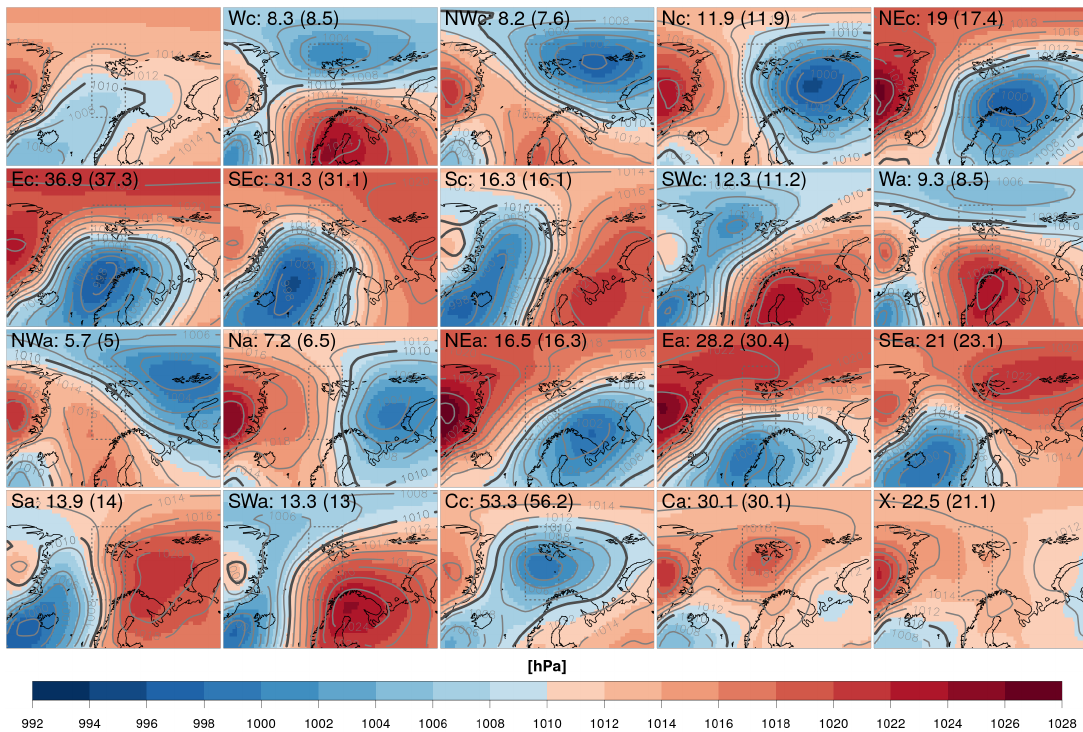
Figure 9. Annual mean sea level pressure from the future (2071–2100, in colours) and current (1971–2000, as contour lines) MPI-ESM-LR simulation (top left) and the decomposition for single weather types. The bold grey line shows the 1010hPa level in the current climate and the dashed box the area used for the weather type classification. In the top left corner, the number of events per year in the future and current (in parentheses) simulation is